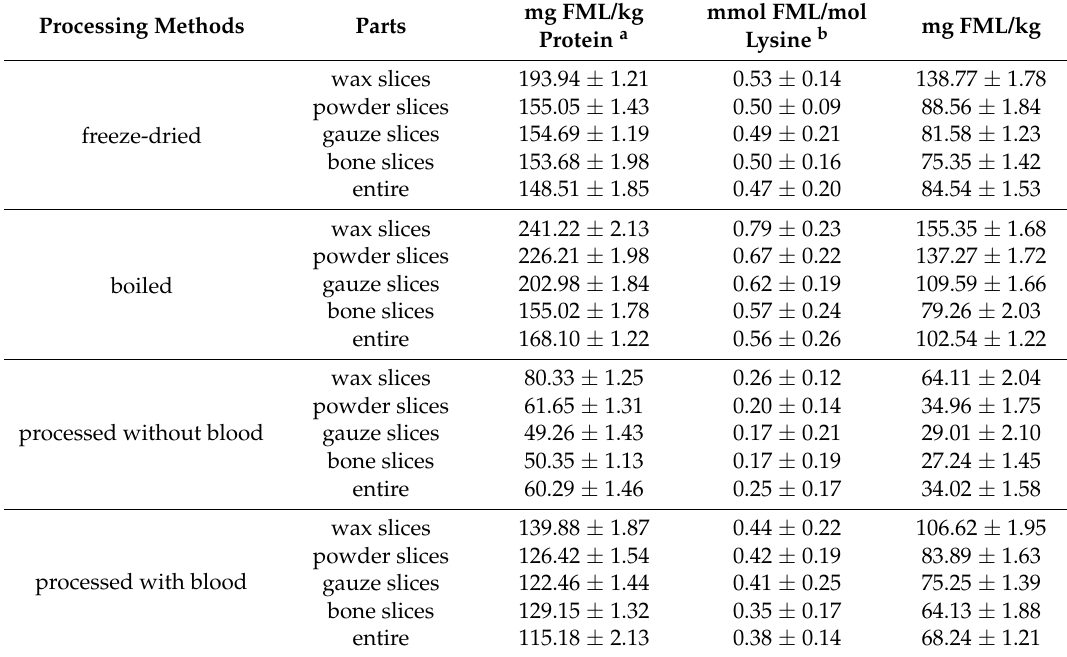
Table 1. Furosine contents in the processed velvet antler, expressed per mg/kg protein, mg/kg, and mmol/mol lysine ( x ± SD, n =